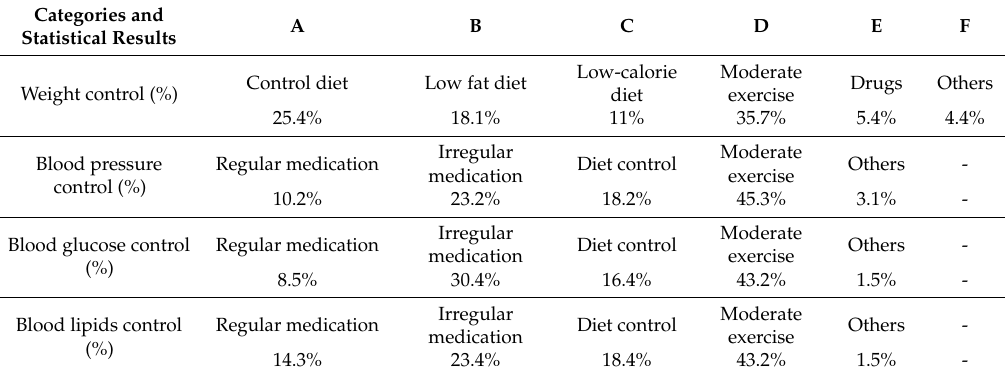
Table 3. Methods of controlling body weight, blood sugar, blood pressure and blood